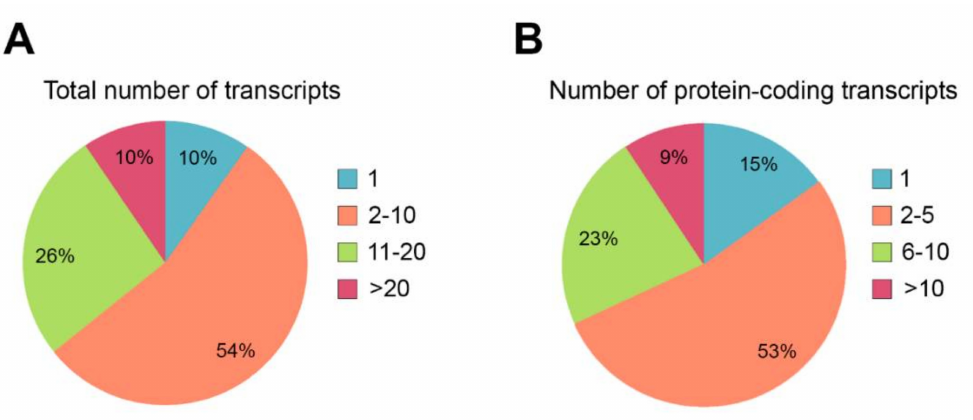
Figure 3. Quantification of alternative splicing events described in genes causing IRDs. ( A ) Per- centage of IRD genes presenting alternative splicing events. Only 10% of the IRD genes produces a unique transcript, and most genes (54%) generate between 2 and 10 transcripts. ( B ) Percentage of IRD genes showing diverse protein-coding transcripts. Only 15% of the IRD genes produce one protein isoform. Most of the genes (53%) produce between 2 and 5 diverse protein isoforms. The list of genes was obtained from https://sph.uth.edu/retnet/ (accessed on 20 January 2021). Information about the number and type of the transcripts was obtained from https://www.ensembl.org/ (accessed on 20 January 2021). Table 1. List of genes causative of IRDs (https://sph.uth.edu/retnet/ (accessed on 20 January 2021)) showing location, associated disease, number of splice variants and coding transcripts. Genes mentioned in the main text are indicated in bold. Gene Location Associated Disease